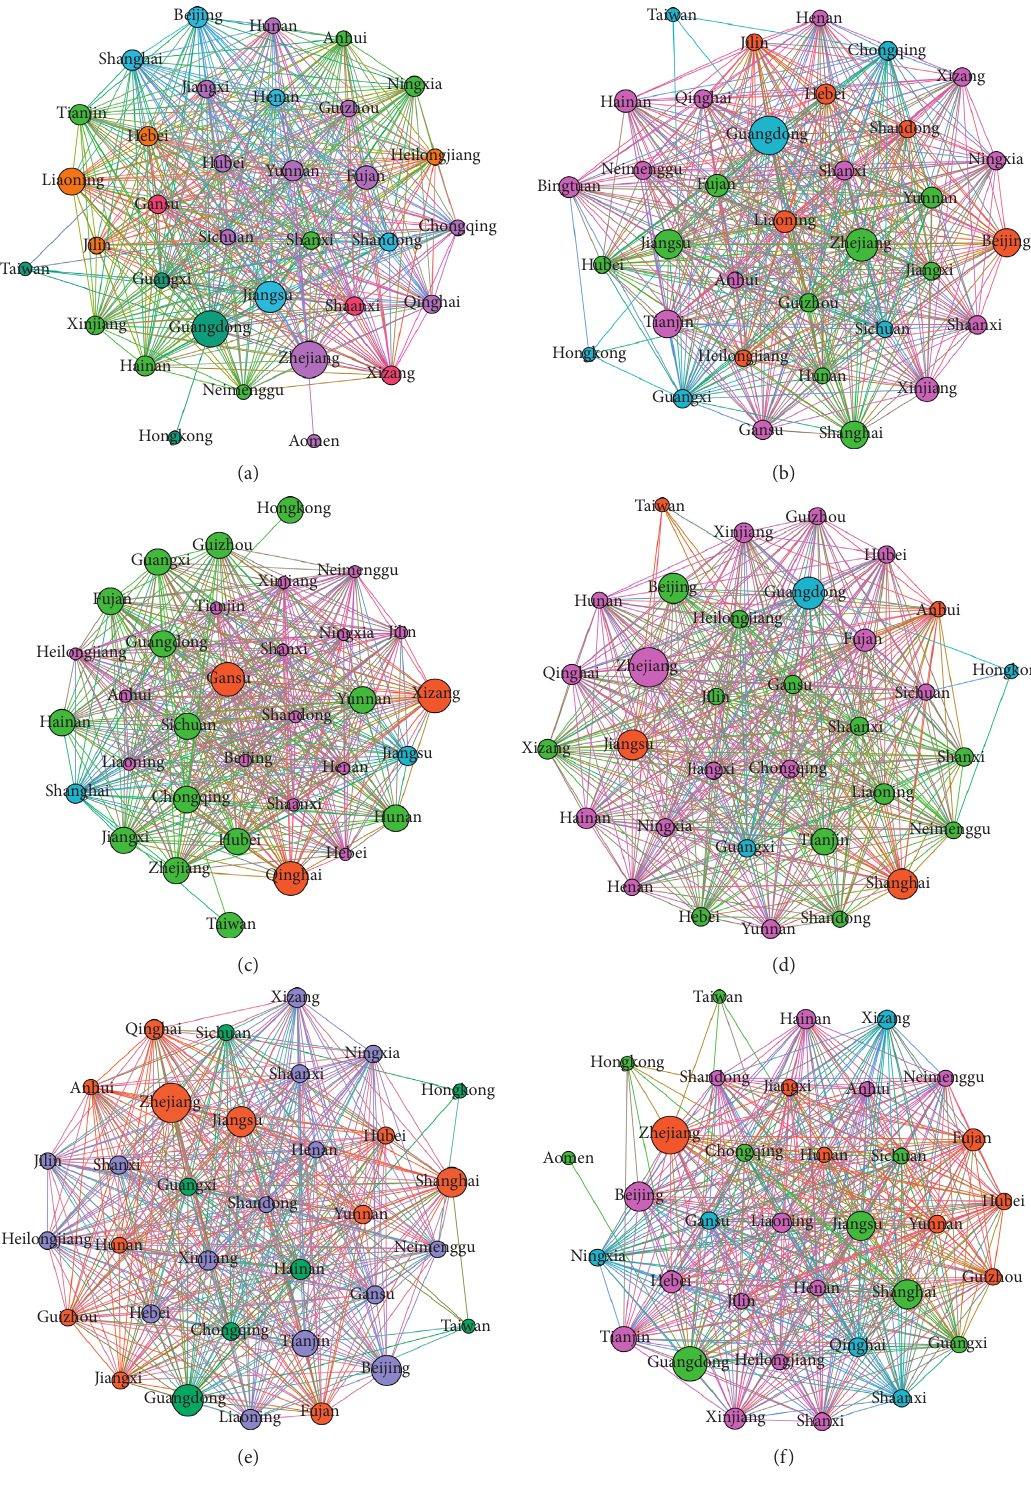
Figure 1: China’s interprovincial population flow network from 2010 to 2015. (a) 2010. (b) 2011. (c) 2012. (d) 2013. (e) 2014. (f)